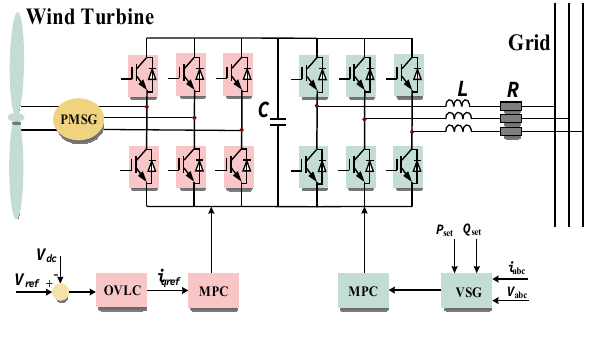
Figure 1. Structure diagram of a wind turbine.